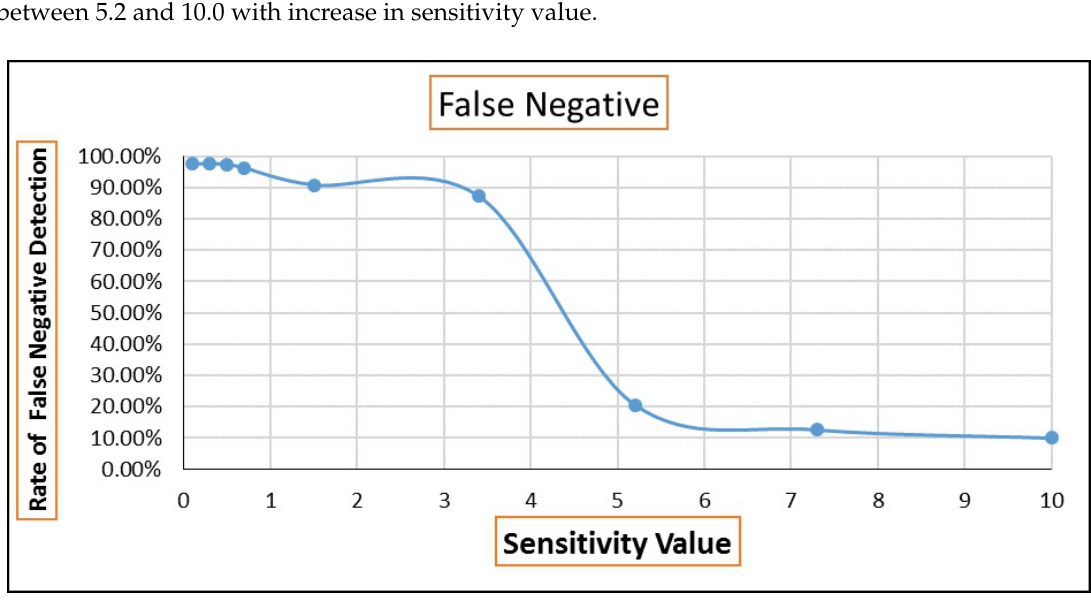
Figure 4. Overall false negative rate seam-carving untouched images with different sensitivity